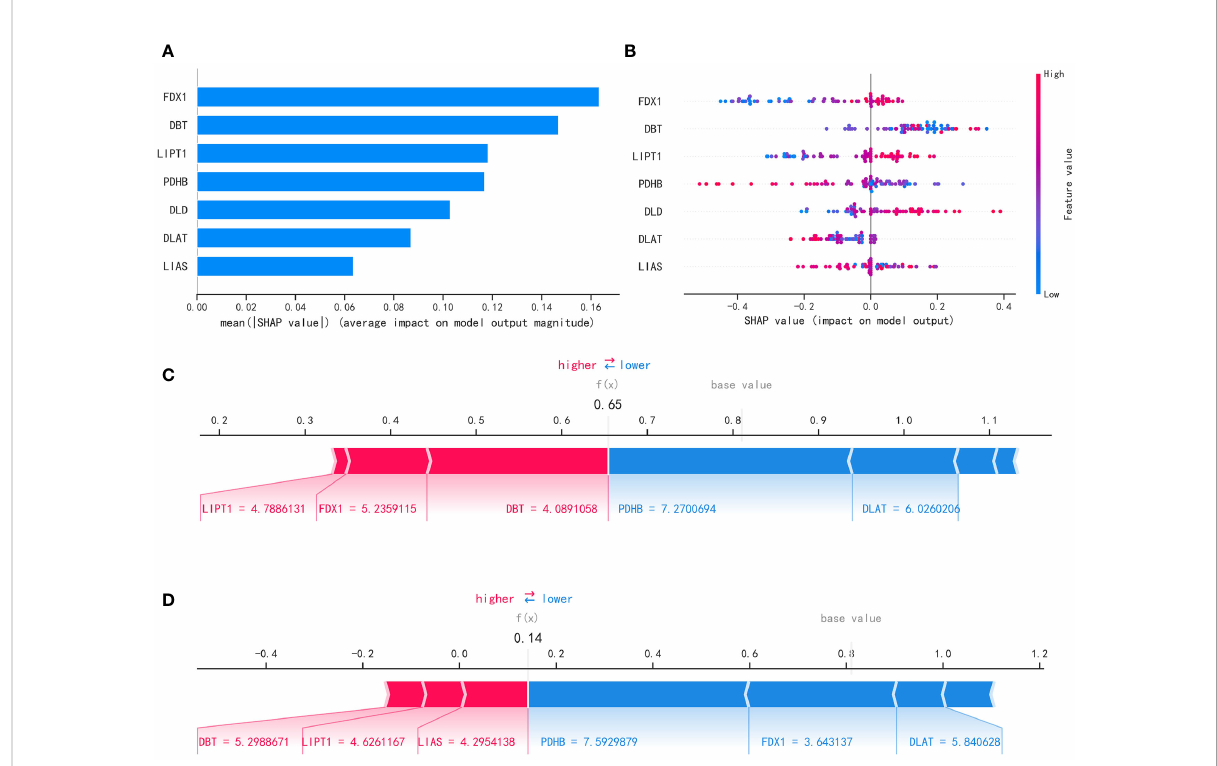
FIGURE 8 Interpretability of the metastasis model. (A) “ SHAP ” package to explain the importance of key variables to the model. (B) Contribution of each variable to the model. (C, D) Prediction of